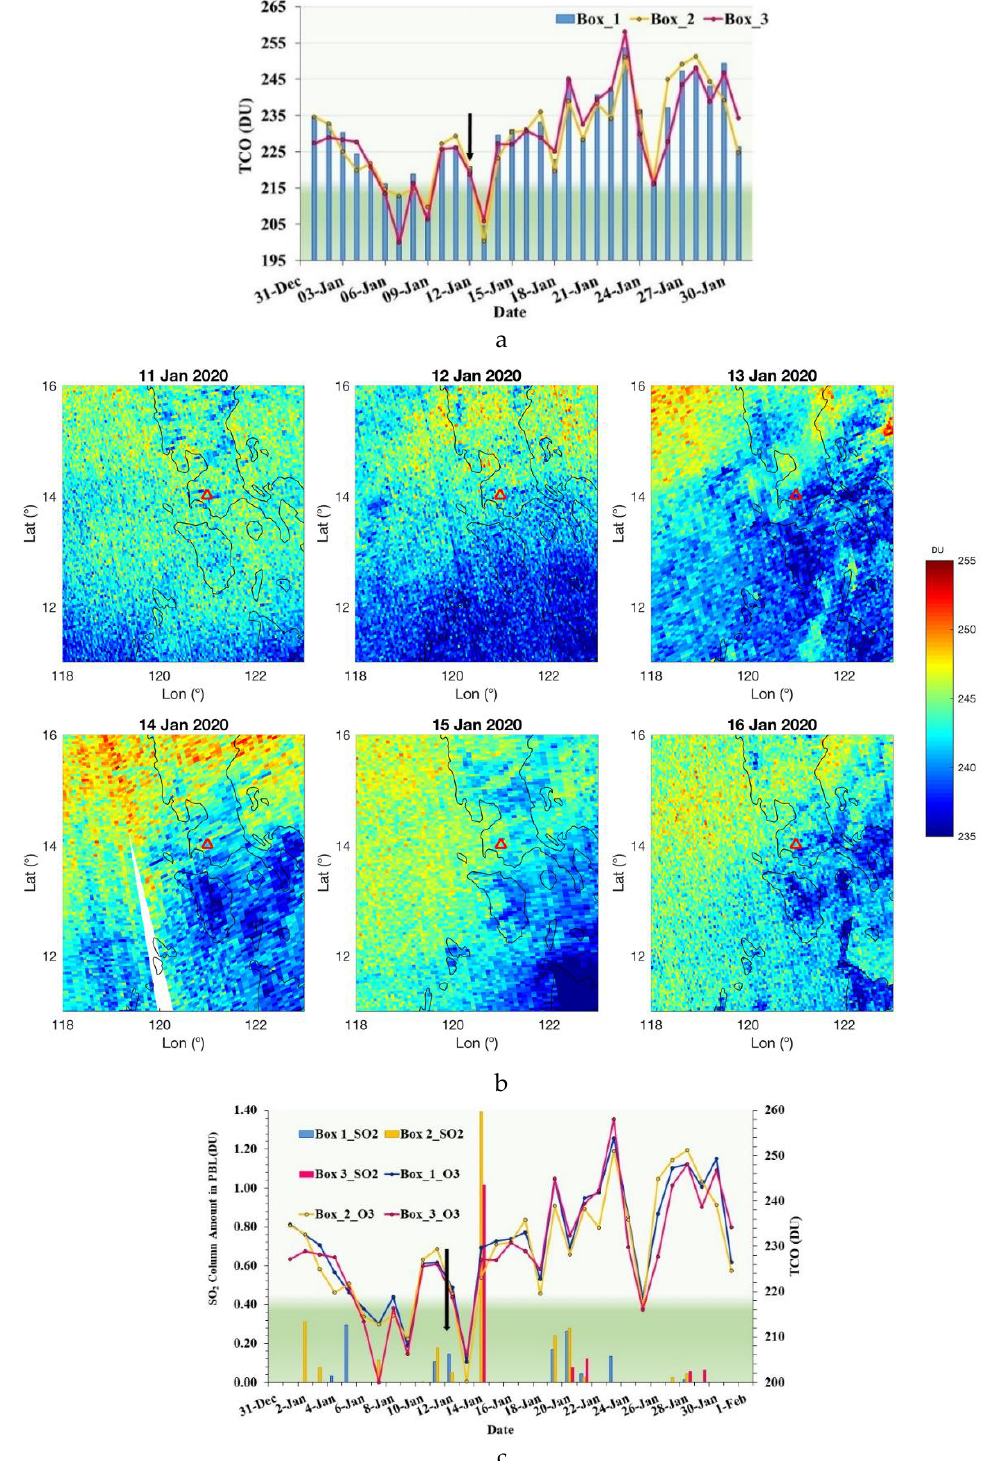
Figure 10. a. Temporal variations of Total Column Ozone (TCO) observed by an Atmospheric Infrared Sounder (AIRS) over Box 1 to 3 during January 2020. The downward black arrow shows the day of the volcanic eruption. b. Spatial distribution of the total vertical column of TROPOMI Ozone from 11 to 16 January 2020 around the Taal region observed by Sentinel-5P. The red triangle indicates the geographic location of the Taal volcano. c. Temporal variations of SO 2 and TCO over Box 1 to 3 for the period 1-31 January 2020. The downward black arrow shows the day of the Taal volcano eruption.